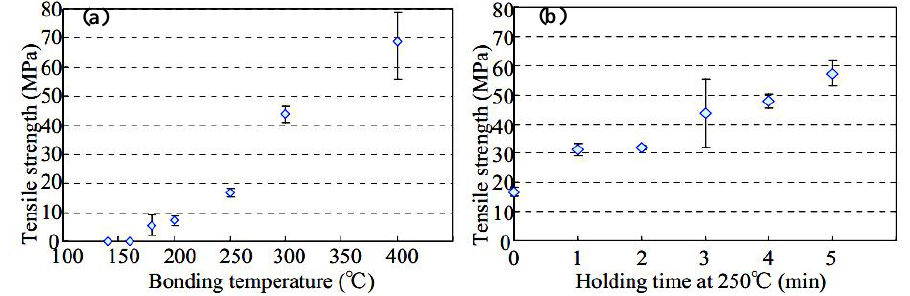
Figure 3. Relationship between bonding parameters and tensile strength of the joints: ( a ) Bonding temperature; ( b ) Holding time at 250 °C. Reproduced with permission from [118].